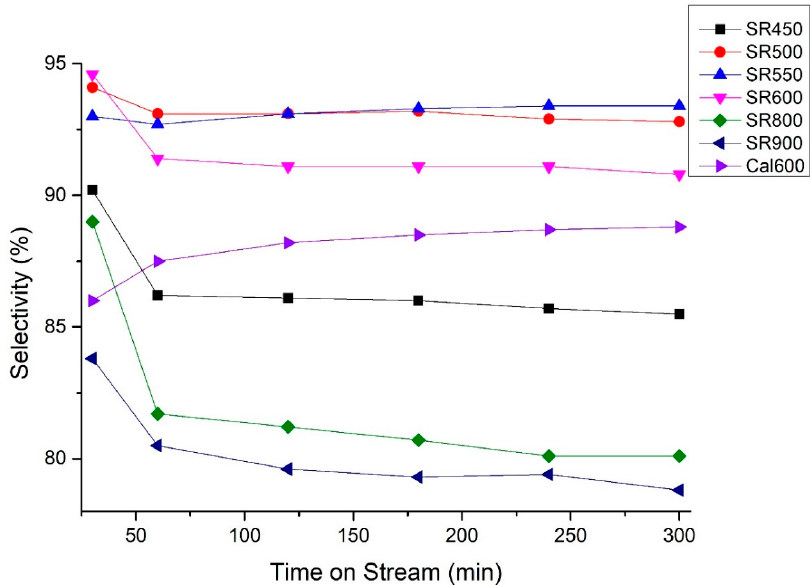
Figure 2. Propylene selectivity of Pt–Sn/Al 2 O 3 . Reaction conditions: catalyst weight, 0.1 g; reaction temperature, 600 °C; and flow rate, H 2 :C 3 H 8 = 32:32 (mL/min).